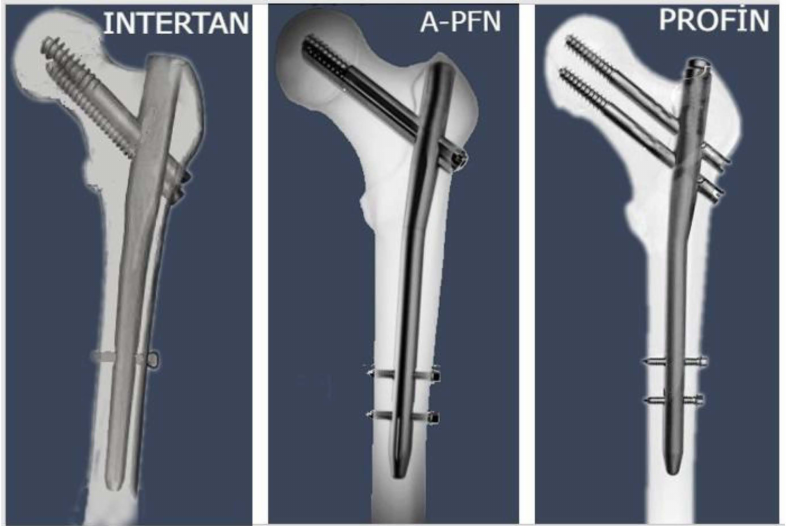
Figure 1. The medical images demonstrate the structural system of the three proximal femoral